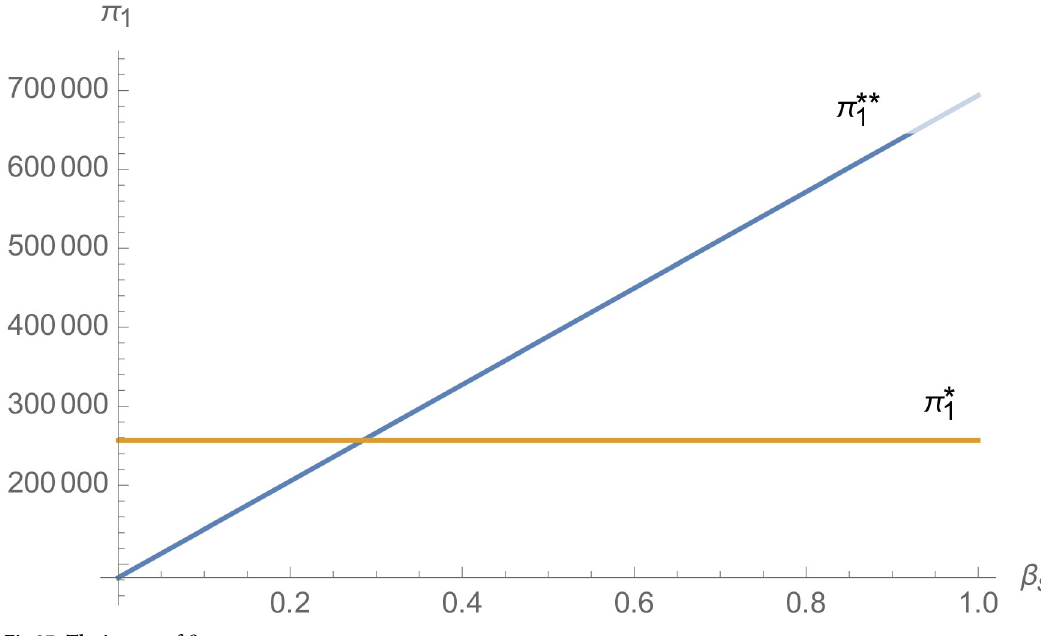
Fig 27. The impact of β